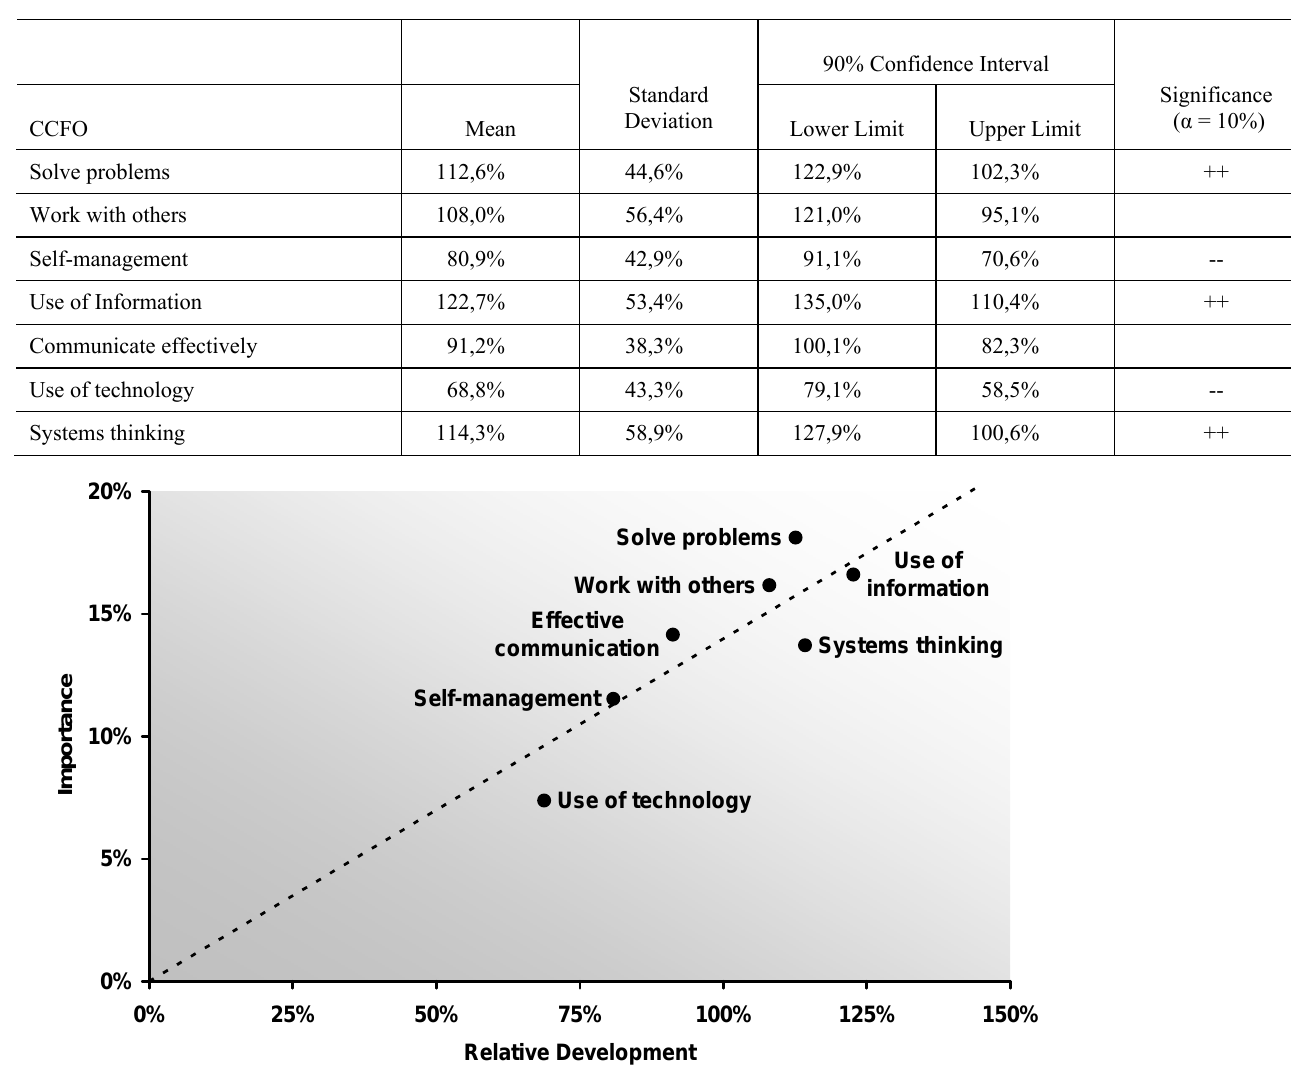
Table 4 : Table of Sample Means and Standard Deviations of Relative Development of CCFOs